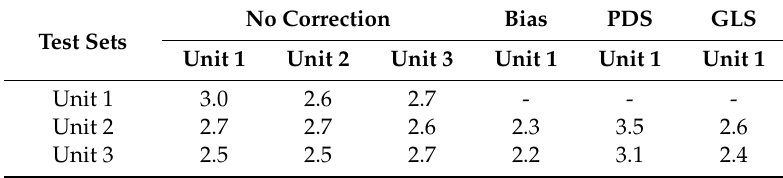
Table 4. The normalized root mean square error of prediction (NRMSEP, %) for ASC.